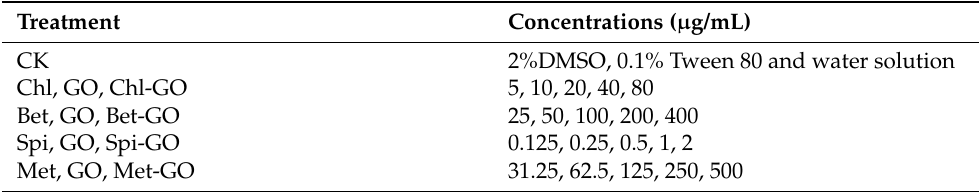
Table 1. Chl, Bet, Spi and Met alone and combined GO bioassayed against S. frugiperda .